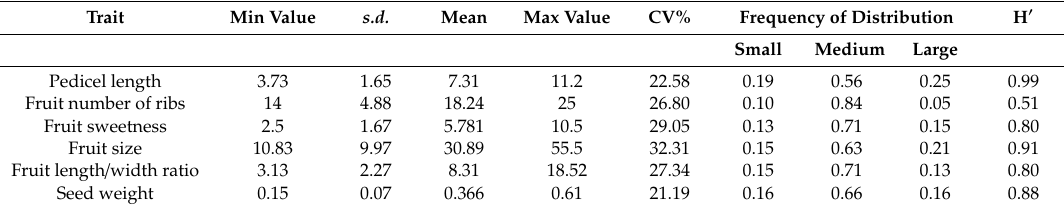
Table 3. Measured characteristics, range of variability, means, coe ffi cient of variation, frequency distribution, and diversity index of the Lebanese snake melon